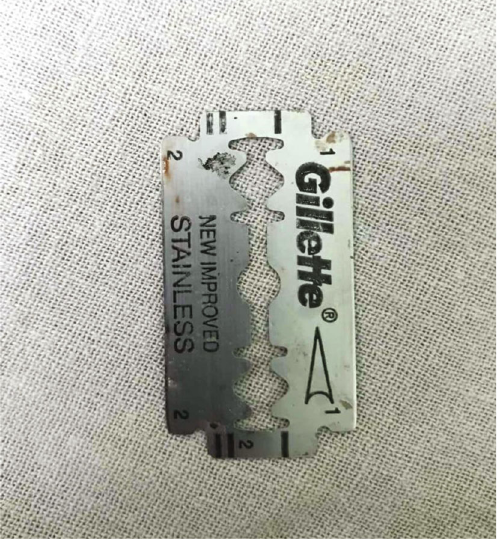
Figure 2: The razor blade after